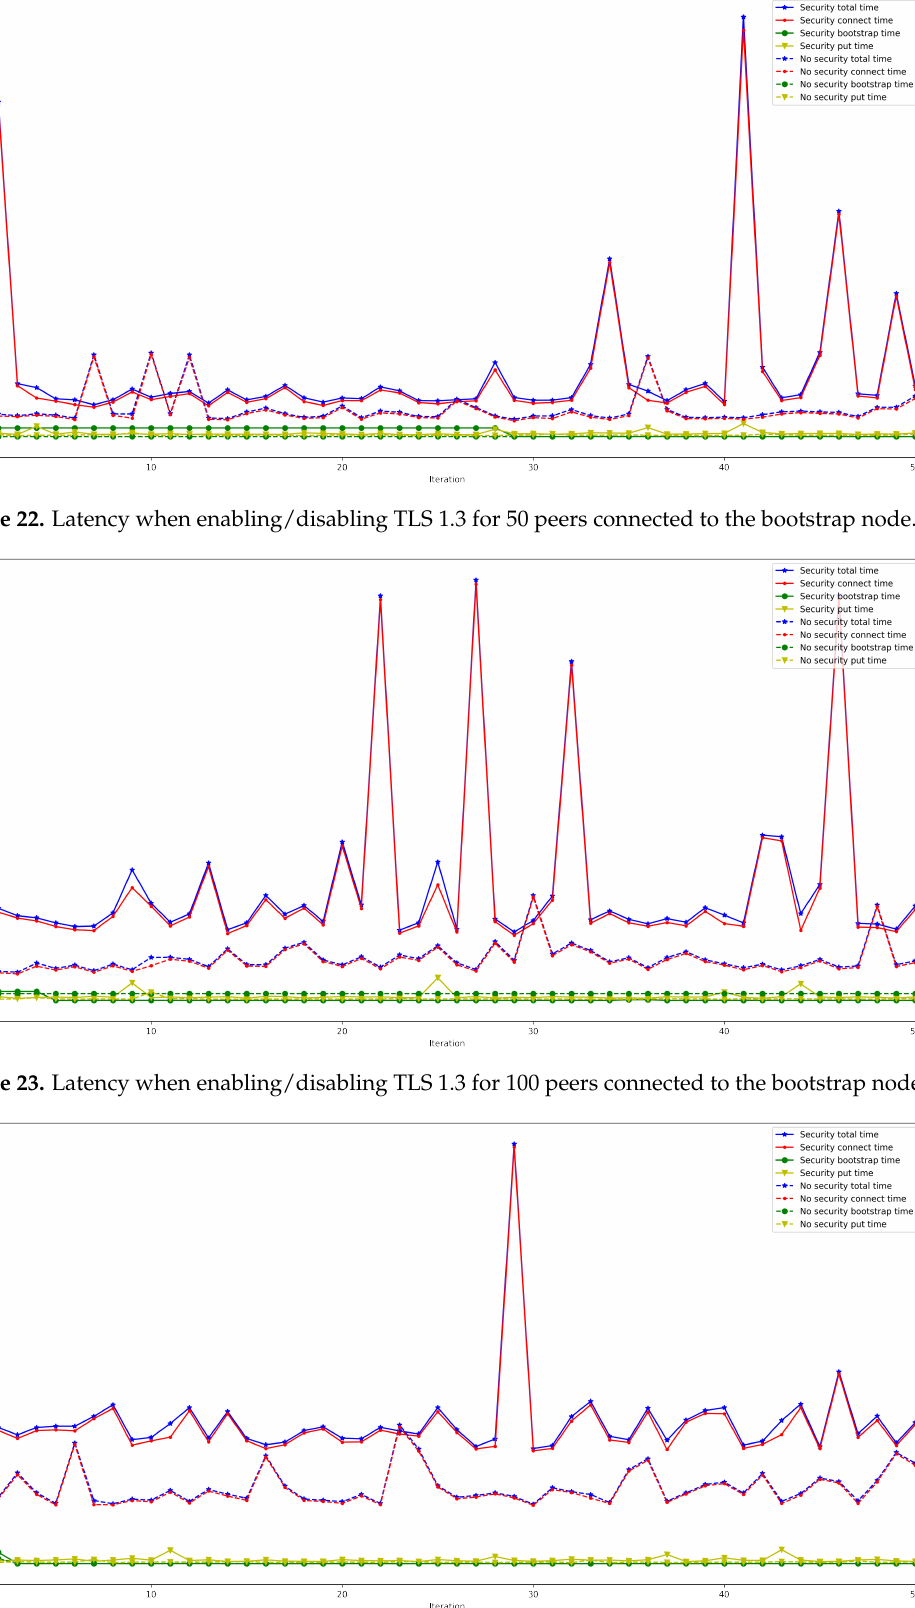
Figure 24. Latency when enabling/disabling TLS 1.3 for 200 peers connected to the bootstrap